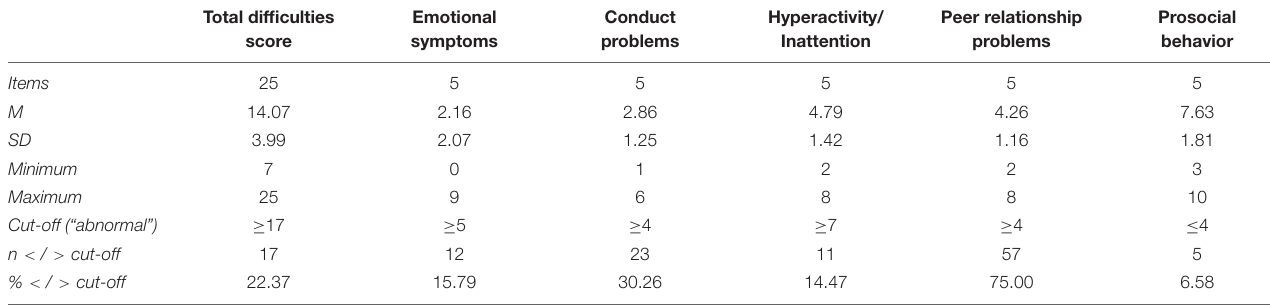
TABLE 4 | Descriptive statistics of SDQ parent version ( n =